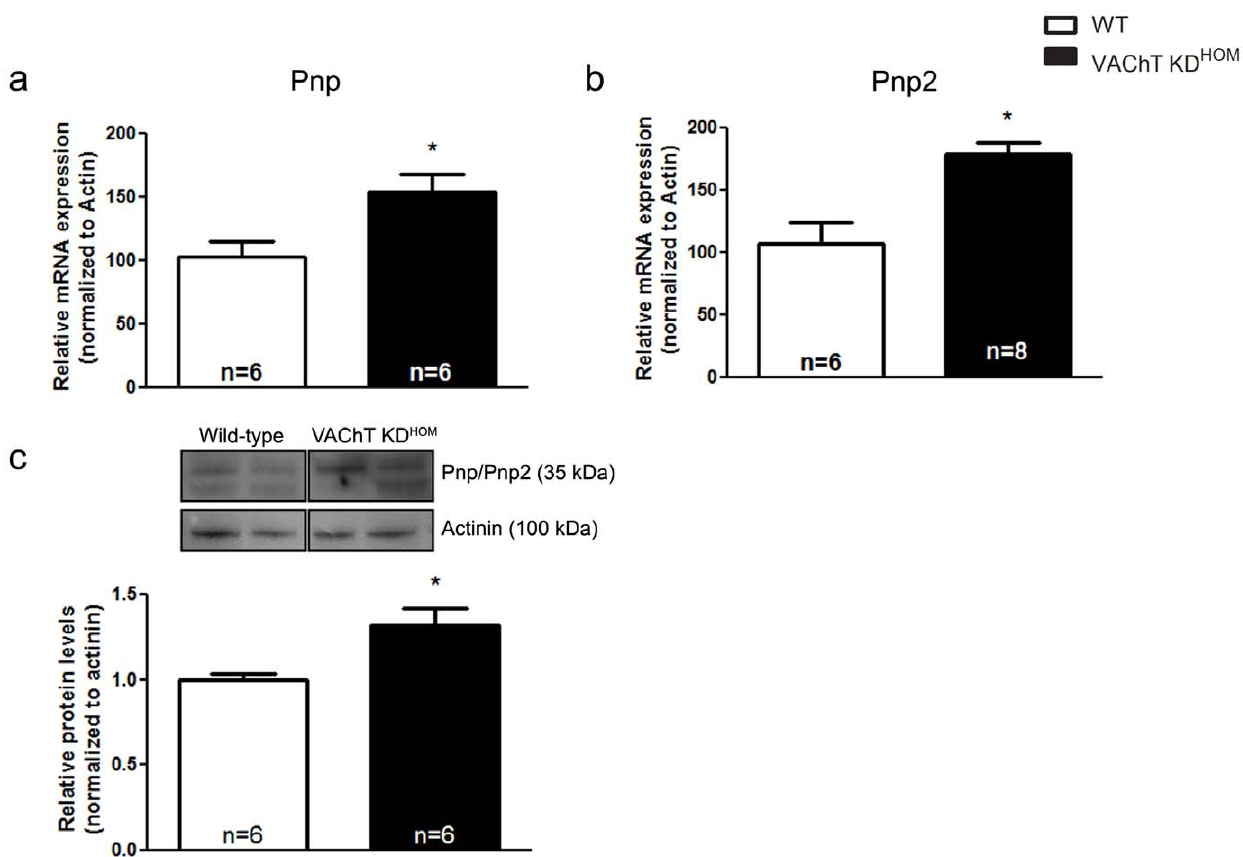
Figure 2. Purine nucleoside phosphorylases are upregulated in the hearts of VAChT KD HOM mice. mRNA expression of purine nucleoside phosphorylase (Pnp; panel a ) and purine nucleoside phosphorylase 2 (Pnp2, panel b ) were upregulated. Pnp/Pnp2 protein content appears to upregulated in VAChT KD HOM animals as compared to wild-type mice ( panel c ). Data represent the mean 6 SEM, with n indicated within bars. *p , 0.05 versus wild-type mice.